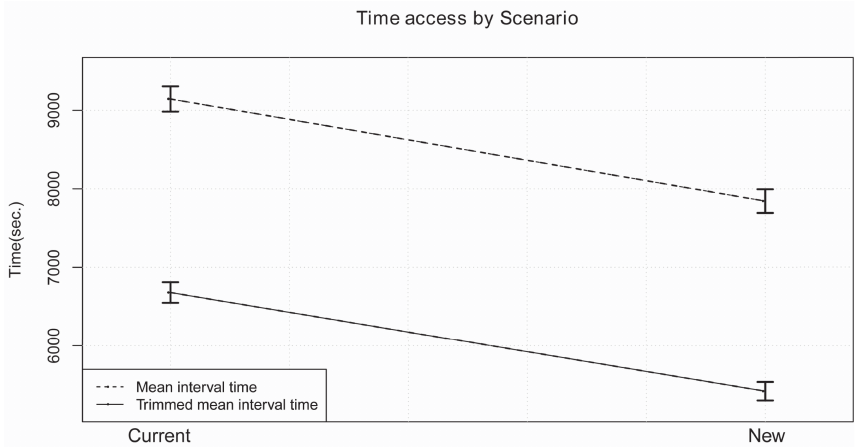
Figure 7. Main effects, network scenario factor (mean and 95 % confidence interval). Effects in terms of diminution in mean time (arithmetic and trimmed means) of present network vulnerability and future network